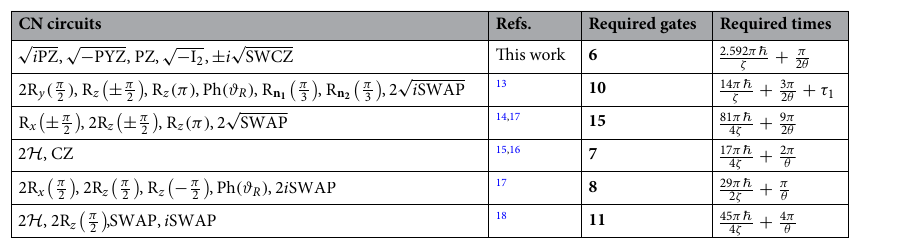
Table 1. CN-gate quantum cost (and realization time) for the current work and previous proposals.